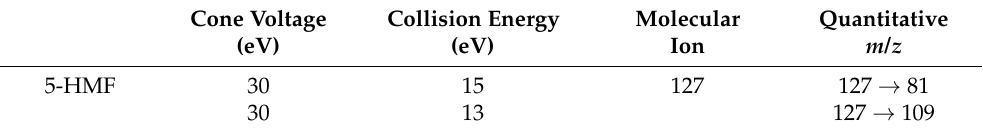
Table A2. UPLC–MS/MS performance of 5-HMF.